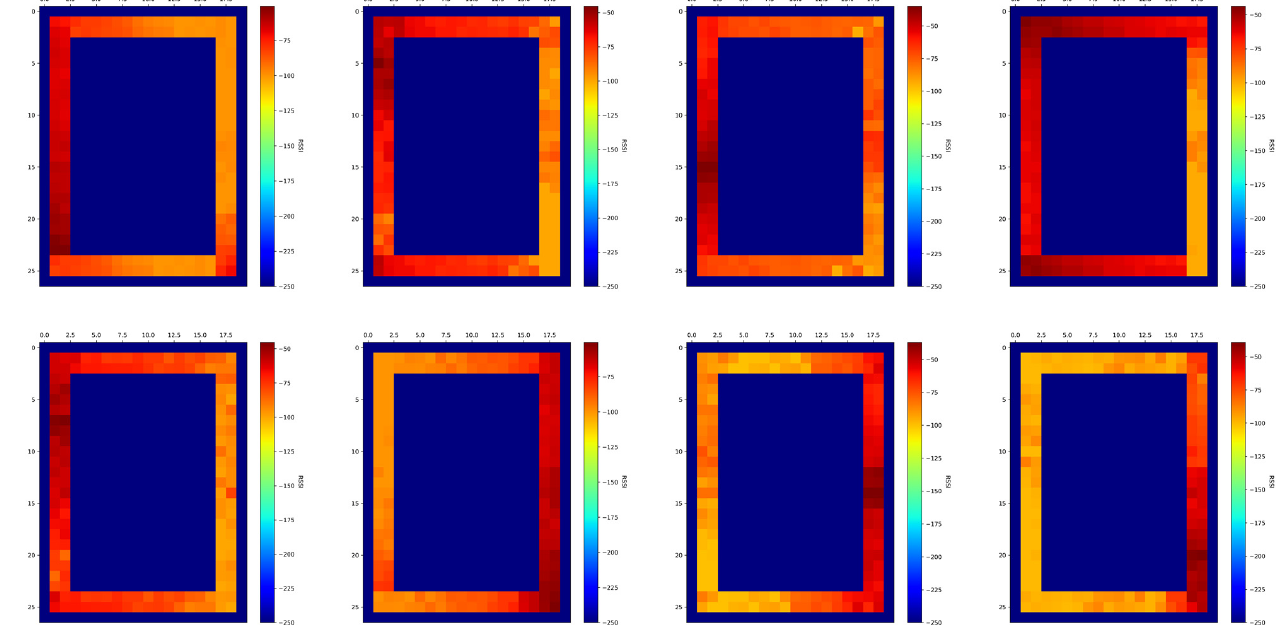
Figure 1. WiFi signal strength heatmap of 8 different APs.